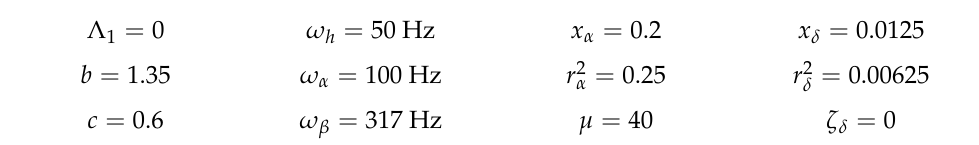
Table 2. Three DOF section parameters for compressible flow.